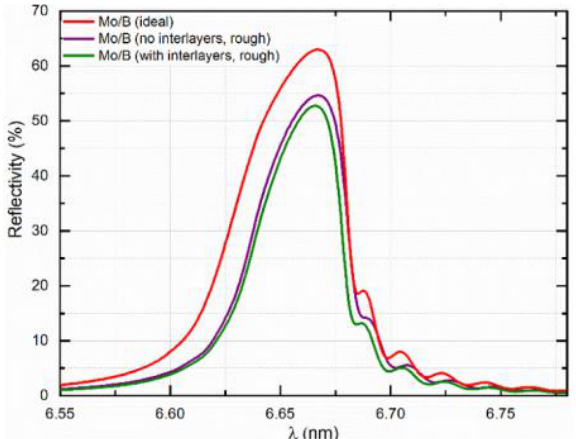
Table 1. Reported reflectivity of various PMMs for BEUV range.